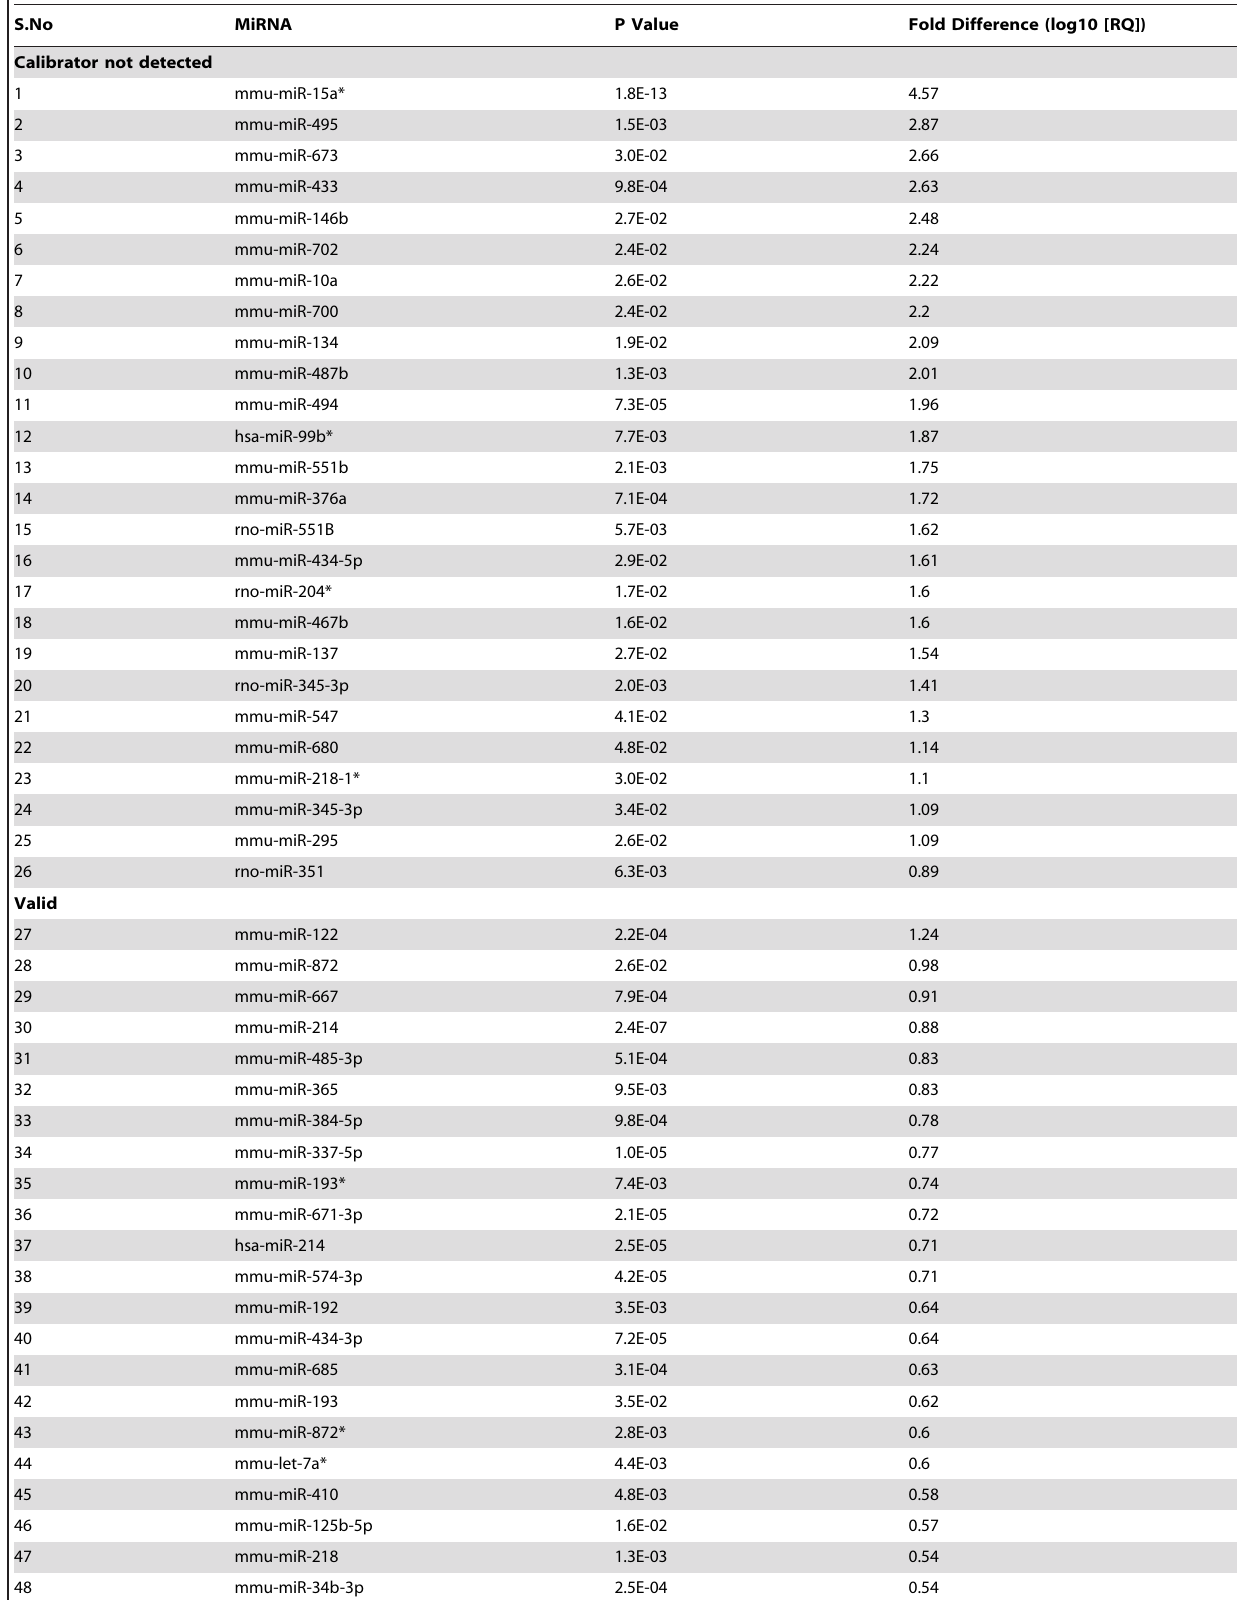
Table 3. Significantly modulated miRNA in